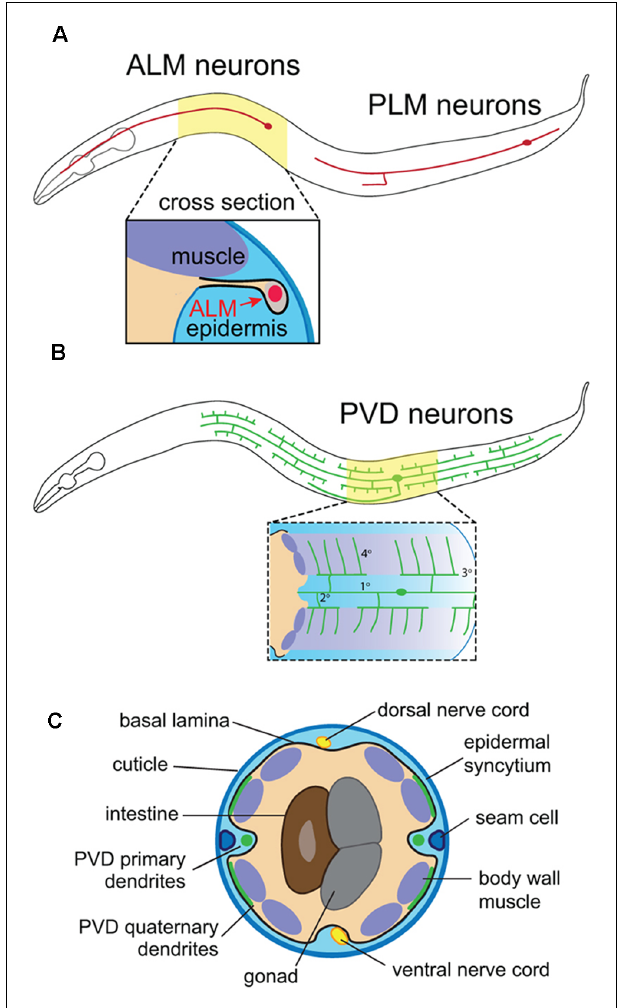
FIGURE 1 | Anatomy of C. elegans somatosensory neurons (SSNs) and skin. (A) Position of the touch receptor neurons ALM and PLM, and schematic depicting epidermal ensheathment of touch receptor neurons (TRNs) shown in cross-section. (B) PVD neuron position and schematic depicting PVD interactions with muscle and epidermal cells. (C) Cross-sectional anatomy of C. elegans